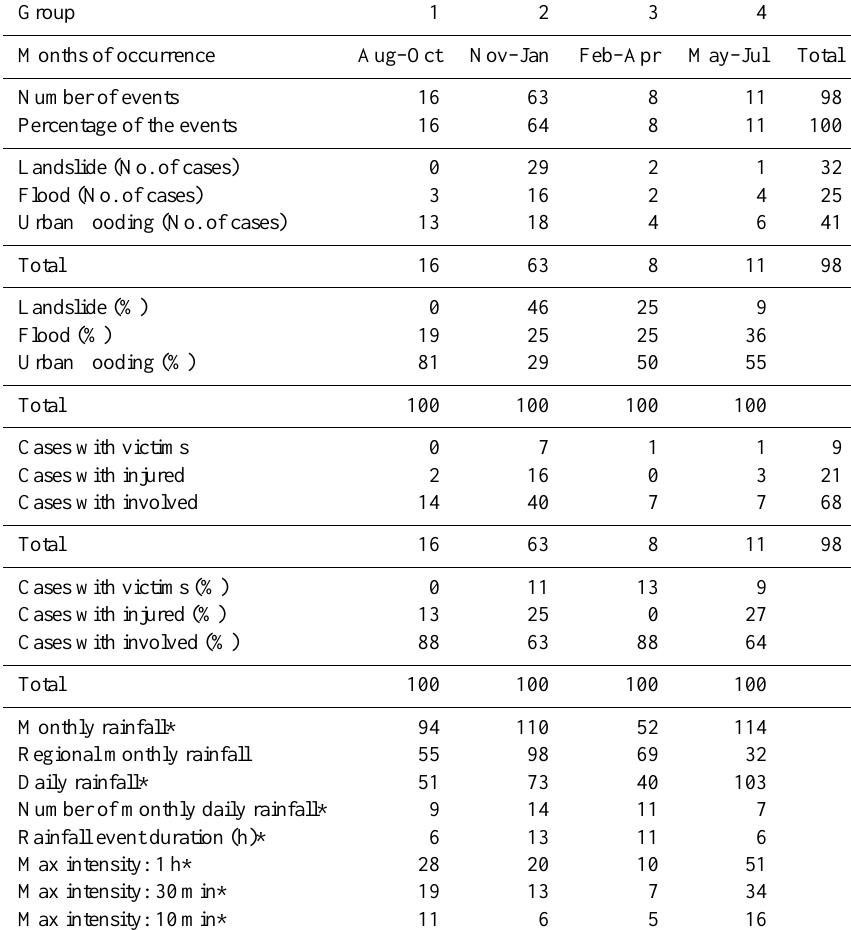
Table 5. Main features of rainfall events causing damage to people along the road network of Calabria in the study period. The asterisk is used to denote average